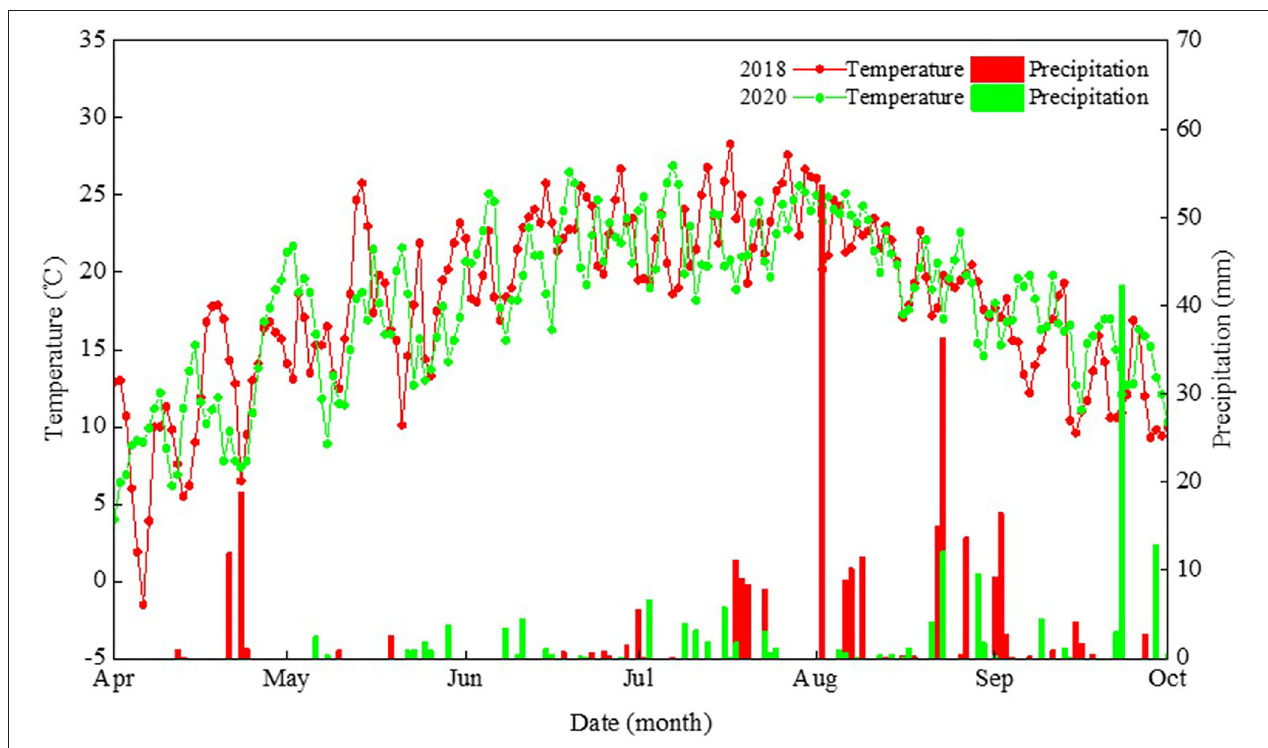
FIGURE 1 | Daily precipitation and mean air temperature during the maize growth period in 2018 and 2020 at the Wuwei Experiment Station in northwestern China.